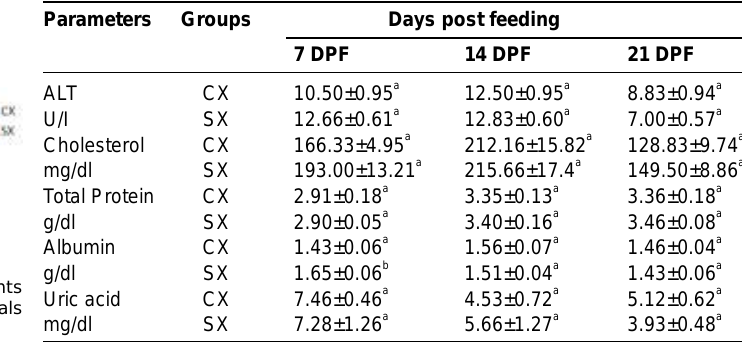
Table-1. Effect of seabuckthorn on different biochemical parameters in Japanese quail at different